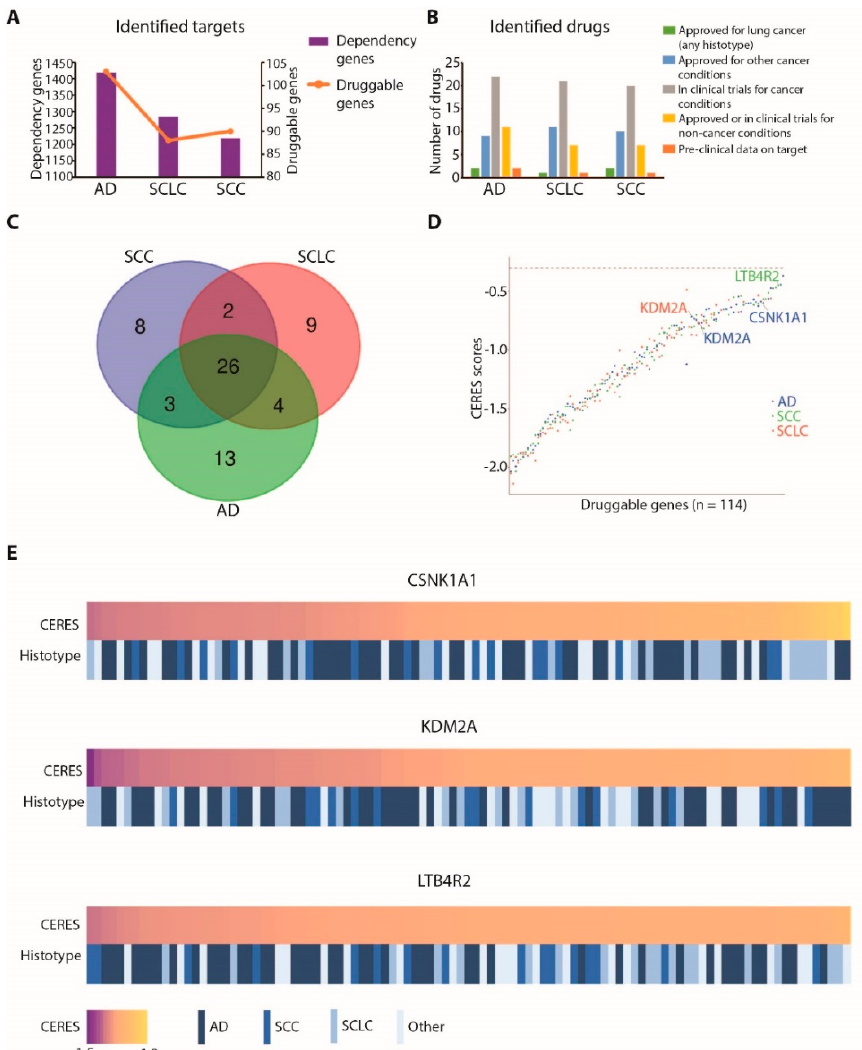
Figure 3. Identification of druggable dependencies in lung cancer: ( A ) bar plot summarizing identified targets and druggable targets in lung cancer cell lines for each considered histotype (bars and left Y axis represent all dependency genes, while the orange line and right Y axis represent the subgroup of druggable genes for each histotype; AD: adenocarcinoma; SCLC: small-cell lung cancer; SCC: squamous-cell carcinoma); ( B ) bar plot representing the number of identified drugs and the status of each drug for each lung cancer histotype; ( C ) Venn diagram summarizing the number of druggable dependency genes for each histotype (AD: adenocarcinoma; SCLC: small-cell lung cancer; SCC: squamous-cell carcinoma); ( D ) median CERES score values in the cell lines of each histotype for the identified druggable genes (values for KDM2A in AD and SCLC cell lines, for CSNK1A1 in AD cell lines, and for LTB4R2 in SCC cell lines are labelled); ( E ) heatmap showing lung cancer cell lines ordered by dependency on CSNK1A1, KDM2A, or LTB4R2 genes, expressed as CERES scores. For each cell line, the histotype is indicated.